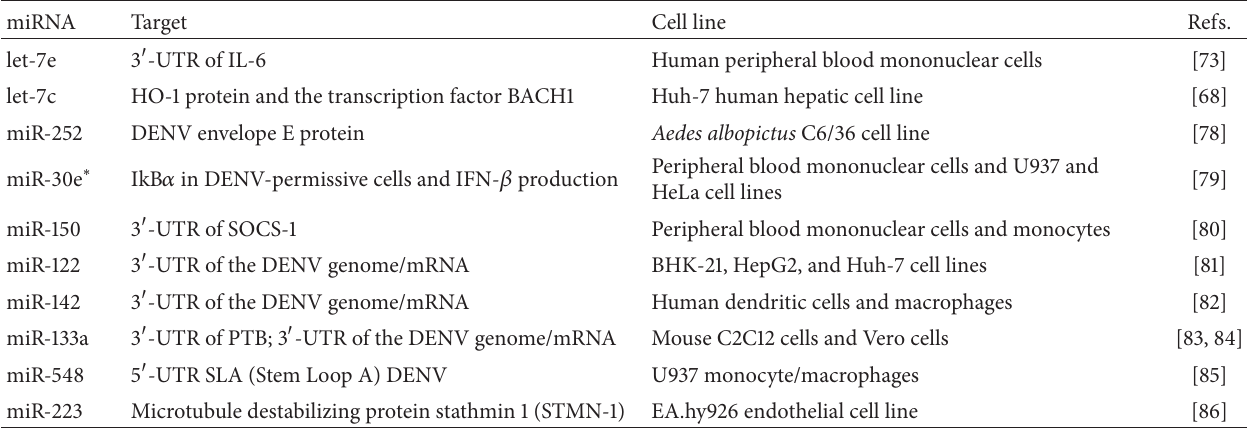
Table 4: Summary of miRs regulating DENV-induced inflammatory response and viral replicative activity.